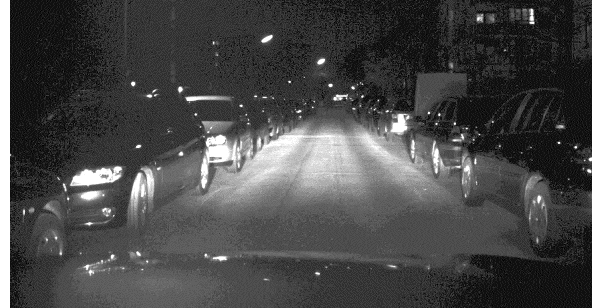
Figure 6: Example image (gray scale), taken at night in a resi- dential area. The illumination of the scene in the image is mainly influenced by the vehicle head lights. For better presentability, the contrast of the image was increased.